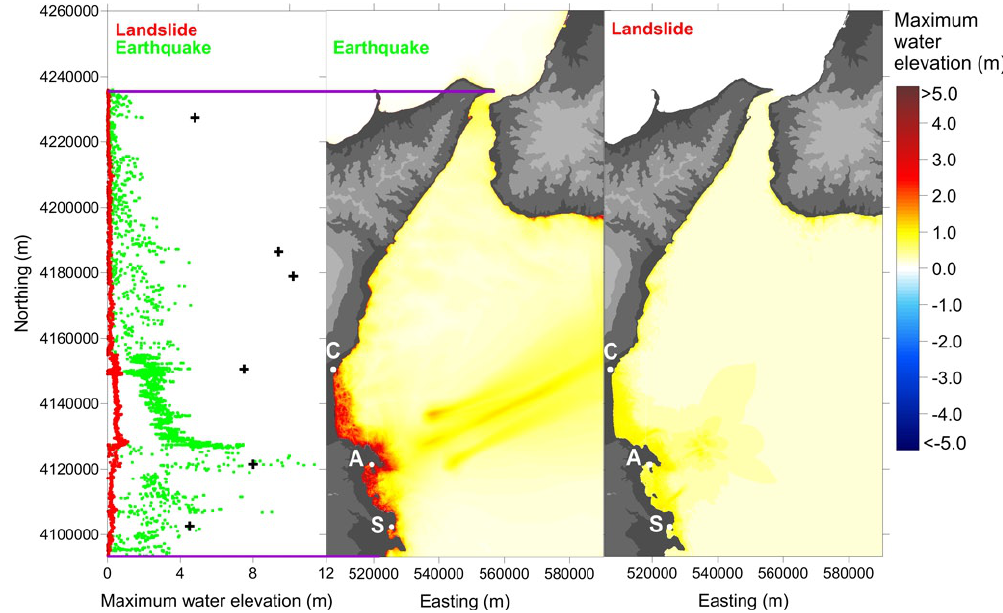
Fig. 6. Maximum water elevations computed for the tsunami generated by the active fault (central panel) and by the landslide (right panel). The left panel shows the comparison of the along-shore maximum water elevation distributions. “C”, “A” and “S” indicate the position of Catania, Augusta and Siracusa, respectively. The black crosses are the run-up values computed by Gerardi et al. (2008) on the basis of the Hills and Mader (1997)